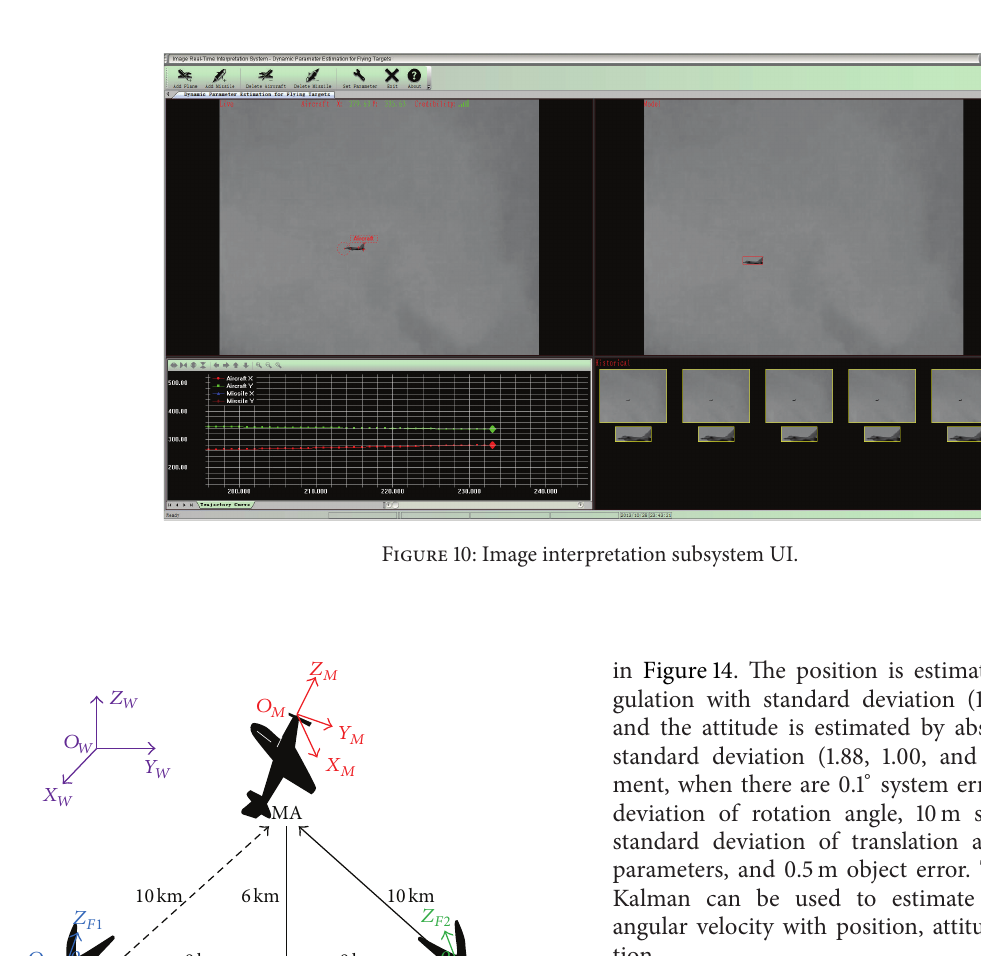
Figure 9: Example of optical characteristic analysis.